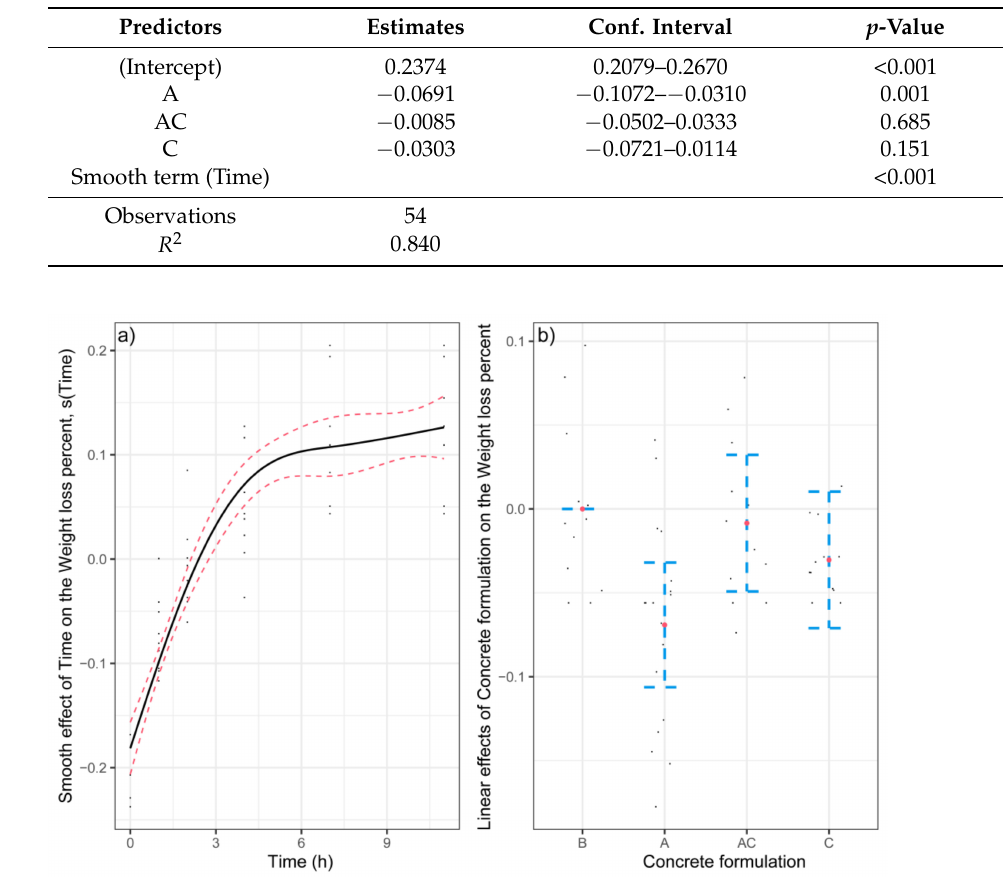
Table 3. Parameter estimates of GAM model for weight loss percent as a function of the concrete formulation and time, including signification analysis of parameters and goodness of fit measure- ments ( R 2 ).